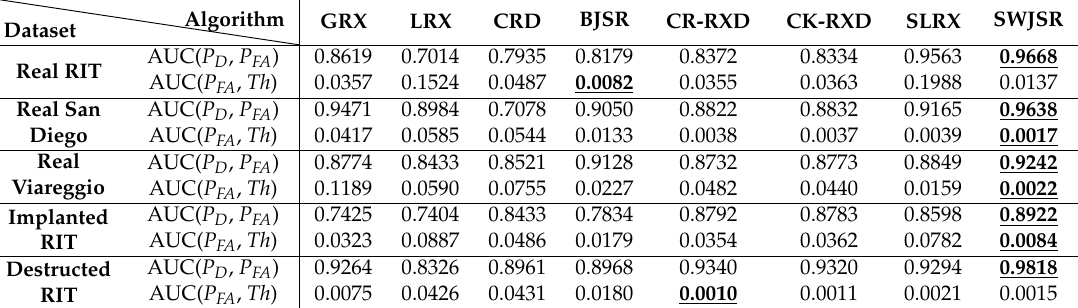
Table 1. Average improvement of efficiency (AUC) of the GRX, local RX algorithm (LRX), CRD,